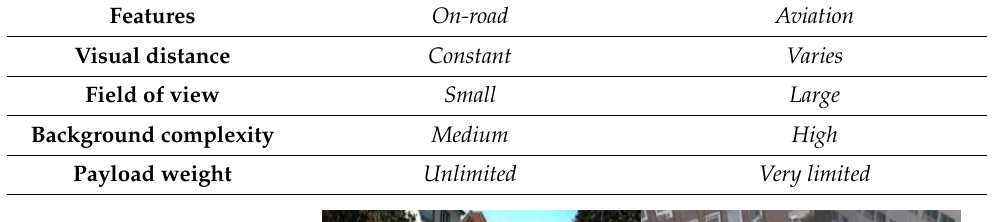
Table 1. Comparison of features considered when detecting objects in an air-to-ground scenario. Features